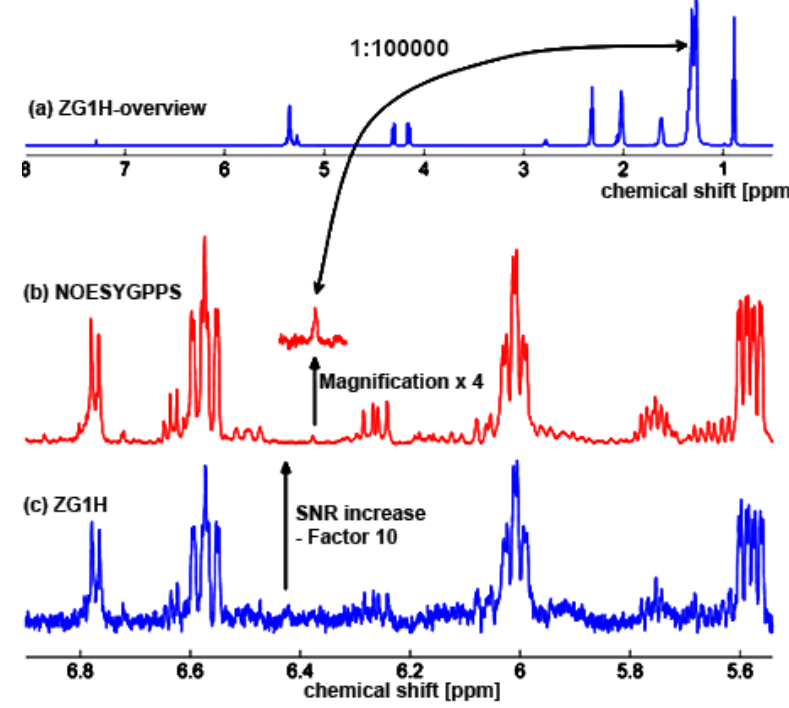
Figure 12. Signal-to-noise (SNR) increase by a factor of ~10 was obtained after suppression of multiple dominating lipid signals due to the increase of the receiver gain. Number of scans and total experimental time were kept constant, i.e., NS = 32 and 4 min, respectively. Adopted, with permission, from [73]. Copyright 2011, Elsevier Ltd.